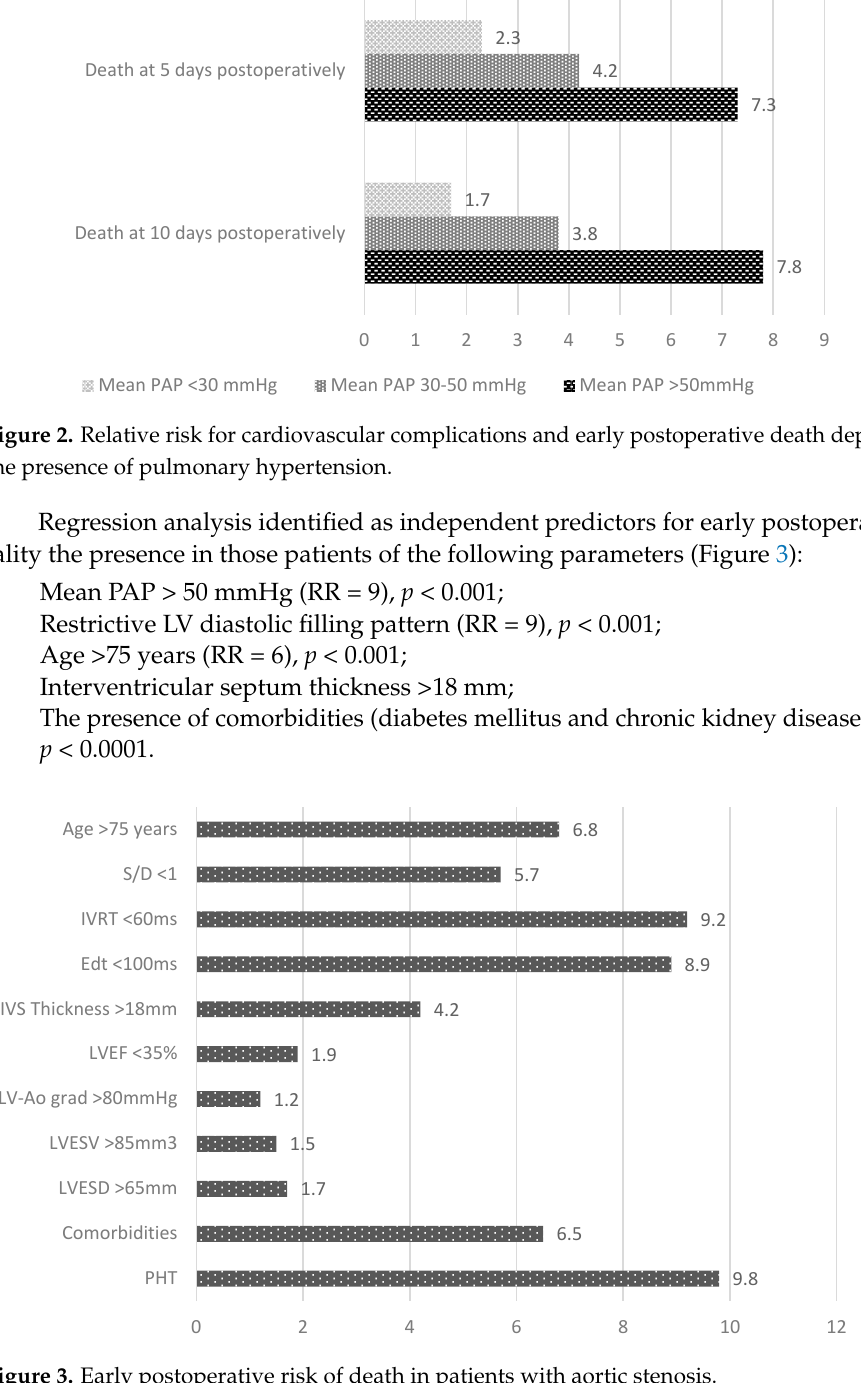
Figure 3. Early postoperative risk of death in patients with aortic stenosis. Parameters of the LV systolic performance (LVEF), severity parameters of aortic lesion (gradient, area) and LV dimensions were not correlated with the increased early postoperative mortality rate in these patients. In Figure 3, the relative risks associated with early postoperative death for the parameters known to increase the mortality rates in surgical AS are presented. Thus, the risk of early death postoperatively was increased about 10 times by the presence of PHT and by 9-fold by the presence of restrictive LV diastolic filling pattern (respectively, by the E wave deceleration time <100 ms by 8.9-fold and by the isovolumetric relaxation time <60 ms by 9.2-fold). In addition, a less than 1 ratio of systolic and diastolic waves in pulmonary veins increased the risk of early death postoperatively by 5.7-fold, patients’ age >75 years by 6.8-fold, and the eccentric left ventricular hypertrophy with interventricular septum thickness >18 mm by 4.2-fold. The early postoperative risk of death was increased as well by the associated comorbidities (diabetes mellitus, chronic obstructive pulmonary disease, and chronic kidney disease). In Figure 4, the relative risks for death in the early postoperative period for the studied group are presented, associated with different parameters known to increase the mortality rates in AS patients having undergone surgery, such as: severe left ventricular hypertrophy, age, and left ventricular systolic performance. The relative risks are presented separately depending on the pulmonary artery pressure value.